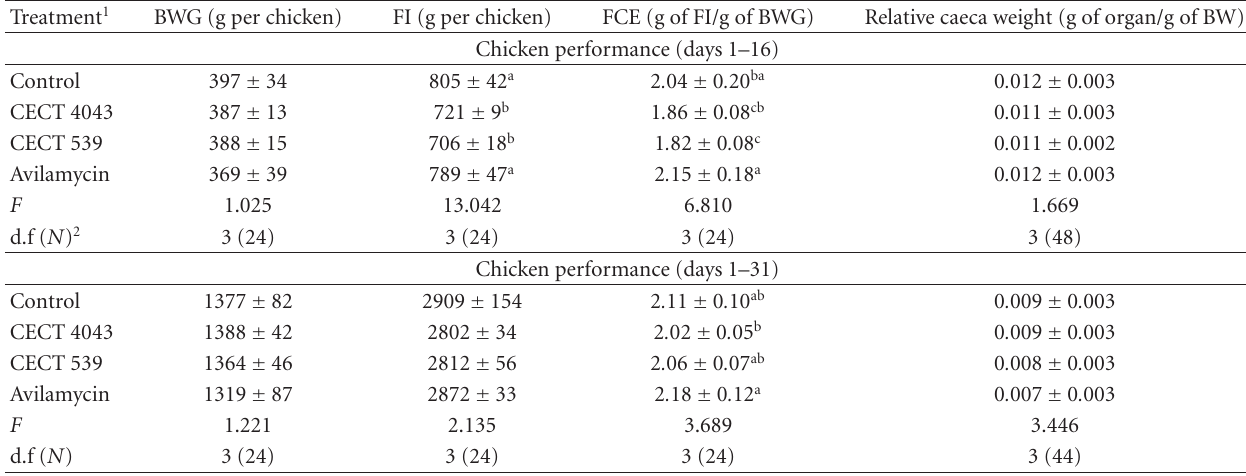
Table 4: E ff ect of dietary probiotic preparations (CECT 4043, CECT 539) or antibiotic (avilamycin) on growth performance parameters of Ross 308 broiler chickens subjected to nutritional stress (experiment 2).